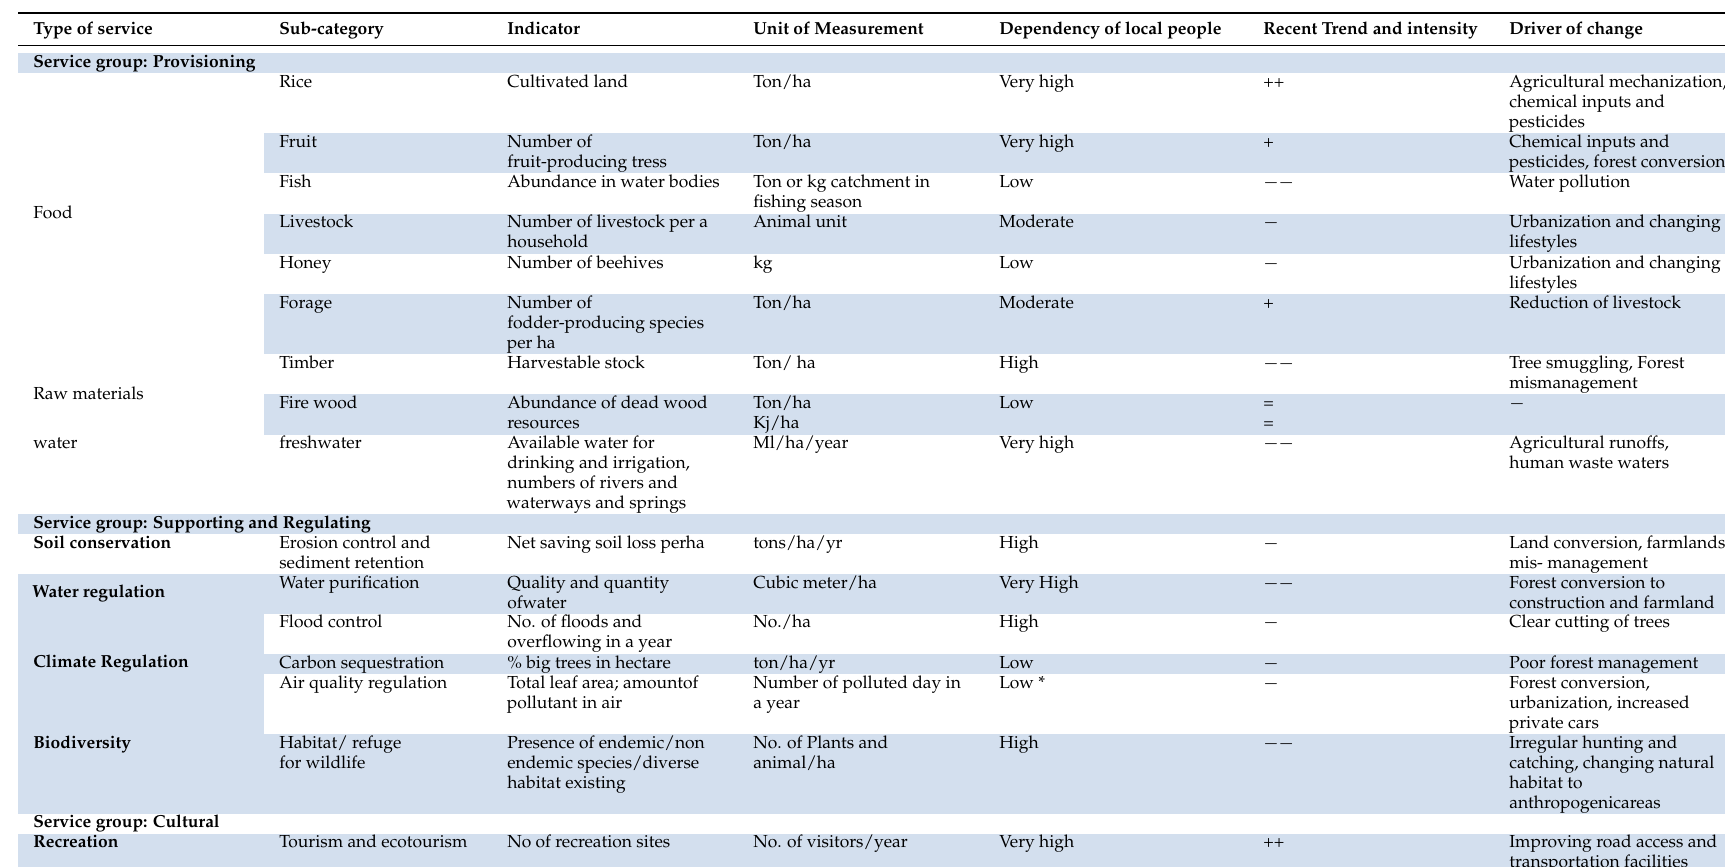
Table 4. Final list of the key ES and their trends based on sampled households responses to interviews. Keys to the status: “++” highly increasing; “+” increasing; “ ´ ” decreasing; “ ´´ ” highly decreasing; “=” no